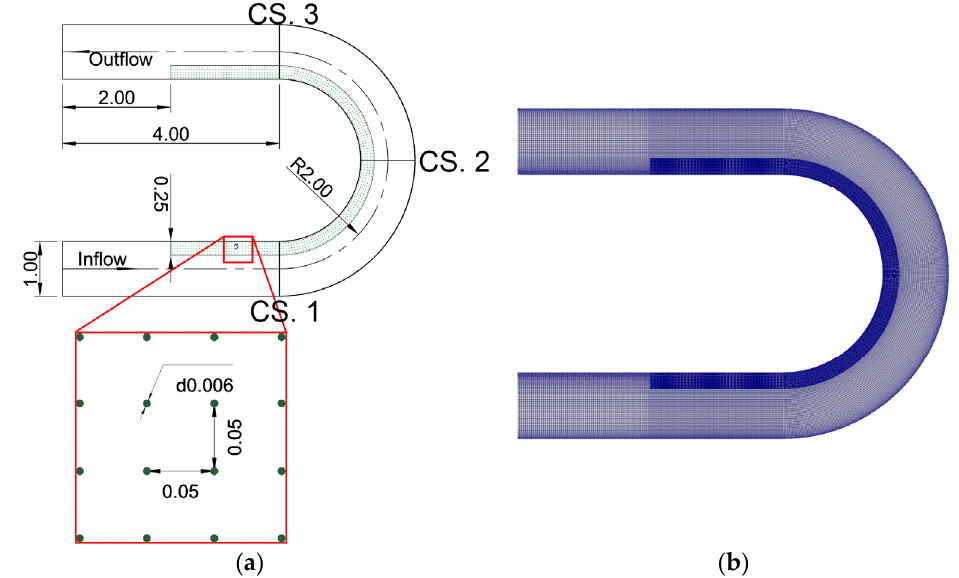
Figure 2. ( a ) The schematic of a U-shape open-channel with an emergent rigid vegetation region on the convex bank and the detailed view of the vegetation region (units: m); ( b ) The local refined calculating